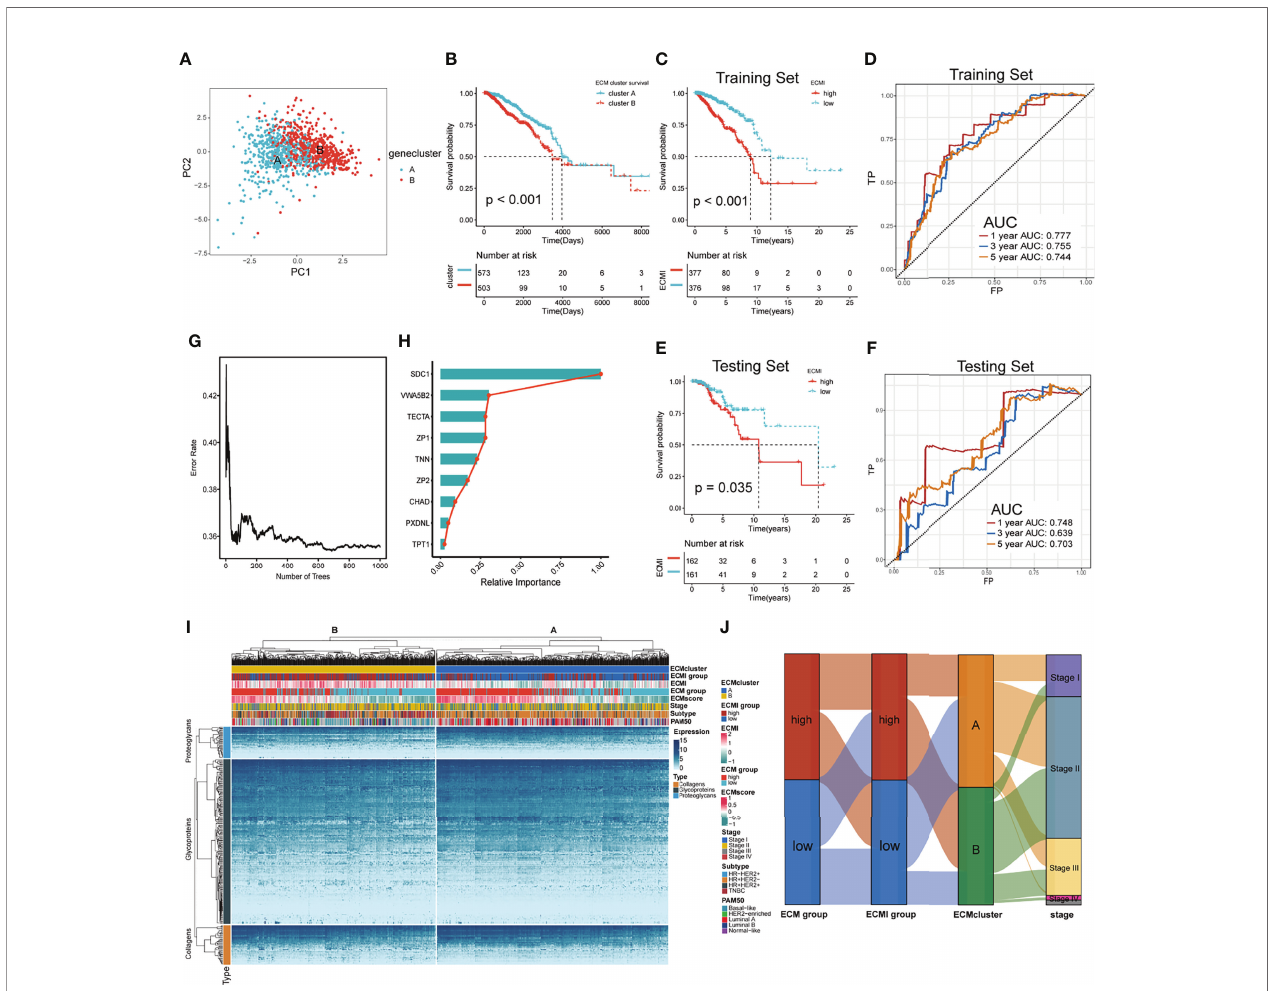
FIGURE 2 | Identi fi cation of the ECM signature in TCGA. (A) Sample clustering by PCA in TCGA dataset. (B) Kaplan – Meier survival analysis of the two clusters in TCGA. (C, D) The Kaplan – Meier survival analysis and ROC curve analysis in the training sets, respectively. (E, F) The Kaplan – Meier survival analysis and ROC curve analysis in the testing sets, respectively. (G) The relation between the error rate and the number of trees in the process of running SurvivalRandomForest algorithm. (H) The relative importance of 9 of the genes consisting the ECMI. (I) Heatmap exhibiting unsupervised clustering of 11 prominent ECMI-related genes for patients in TCGA. Tumor stage, IHC subtype, ECM group, ECMI, ECM score, and PAM50 subtypes are shown as patient annotation. (J) Sanky plot showing the different ECM groups in the ECMI groups, ECM clusters, and tumor